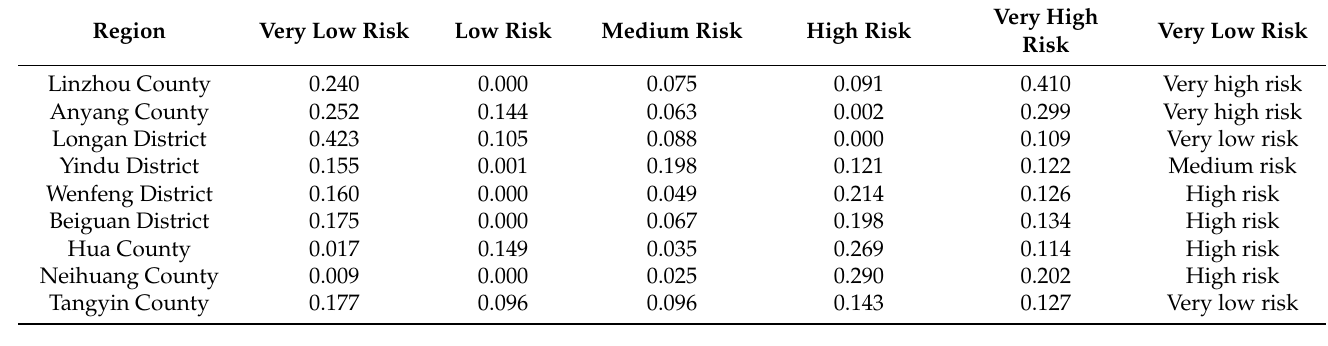
Table 7. Flood risk assessment table of counties and districts in the Anyang Region.